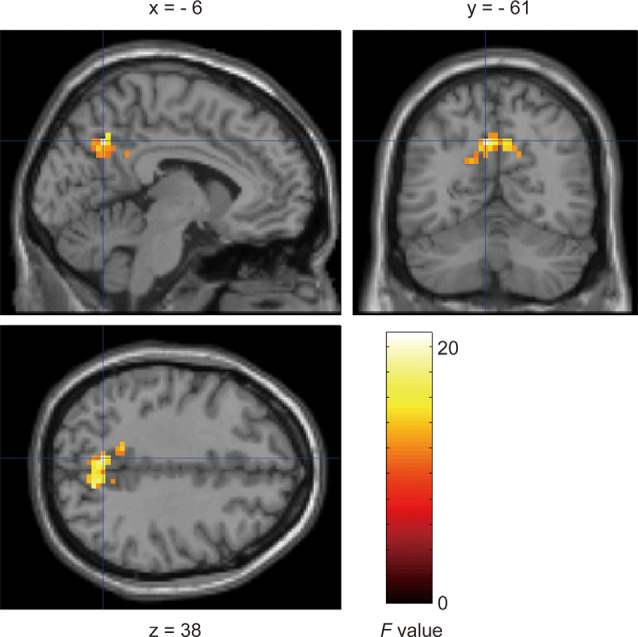
Significant activation observed in the precuneus (BA7/31) bilaterally with an interaction between type of pillar and target position (family-wise error corrected p < 0.05 at cluster level). Uncorrected p-level at p < 0.001 (peak voxels) was applied only for display purposes.